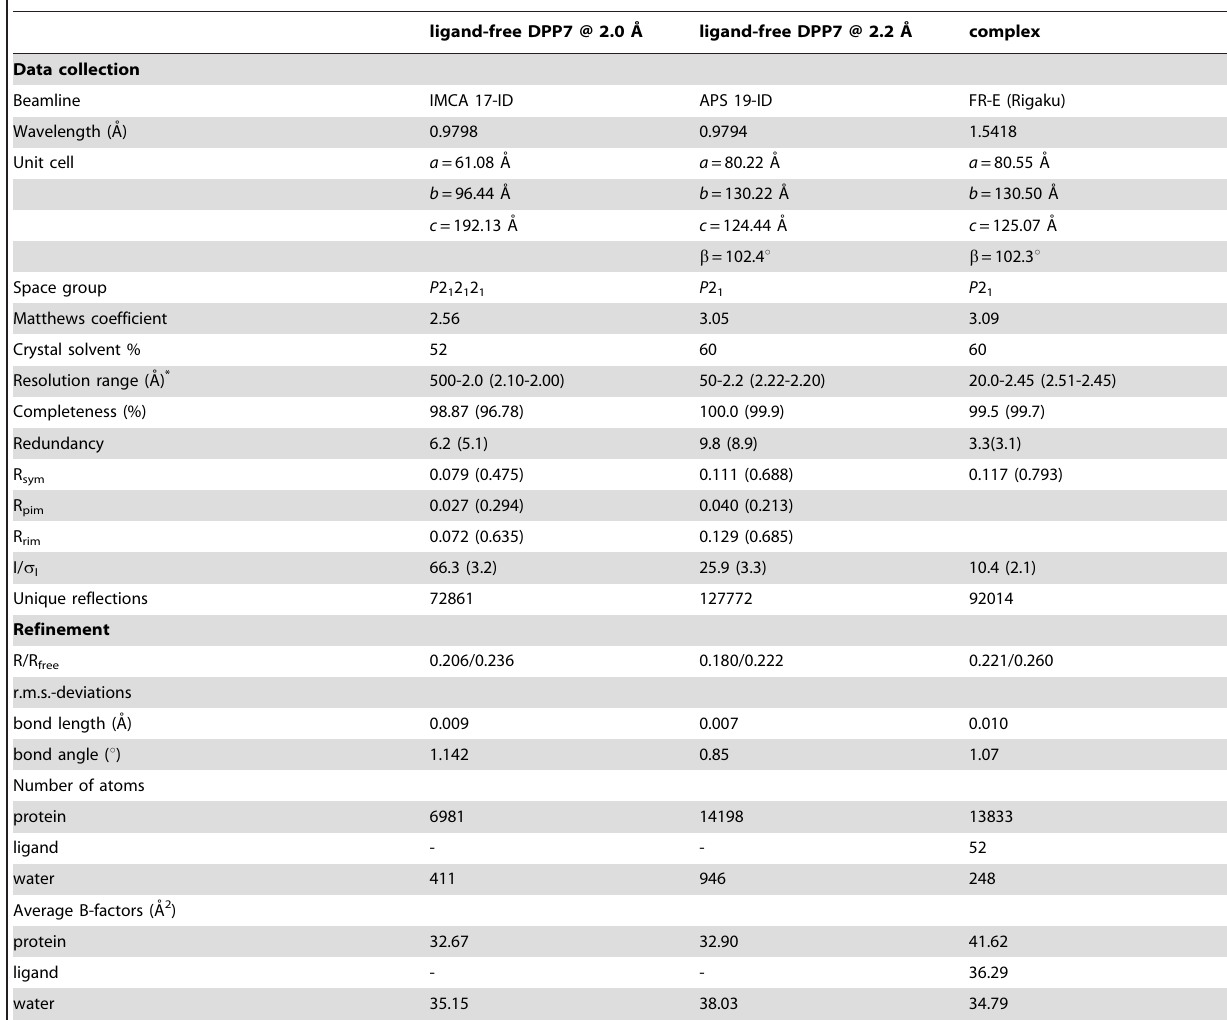
Table 1. Data collection and refinement